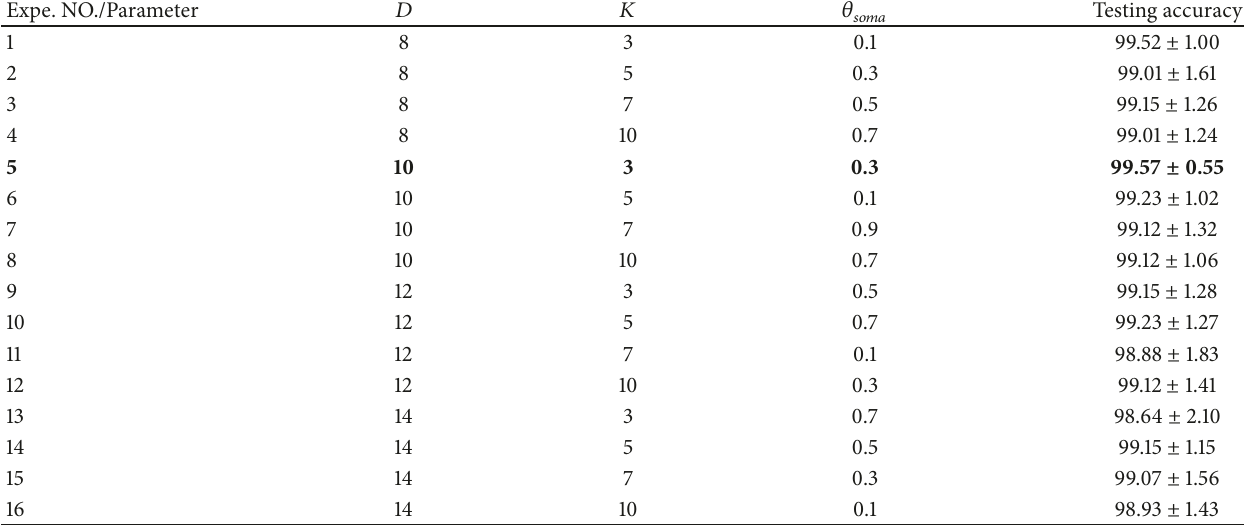
Table 2: 𝐿 16 (4 3 ) orthogonal array and factor assignment of the Qualitative Bankruptcy data set. Expe. NO./Parameter